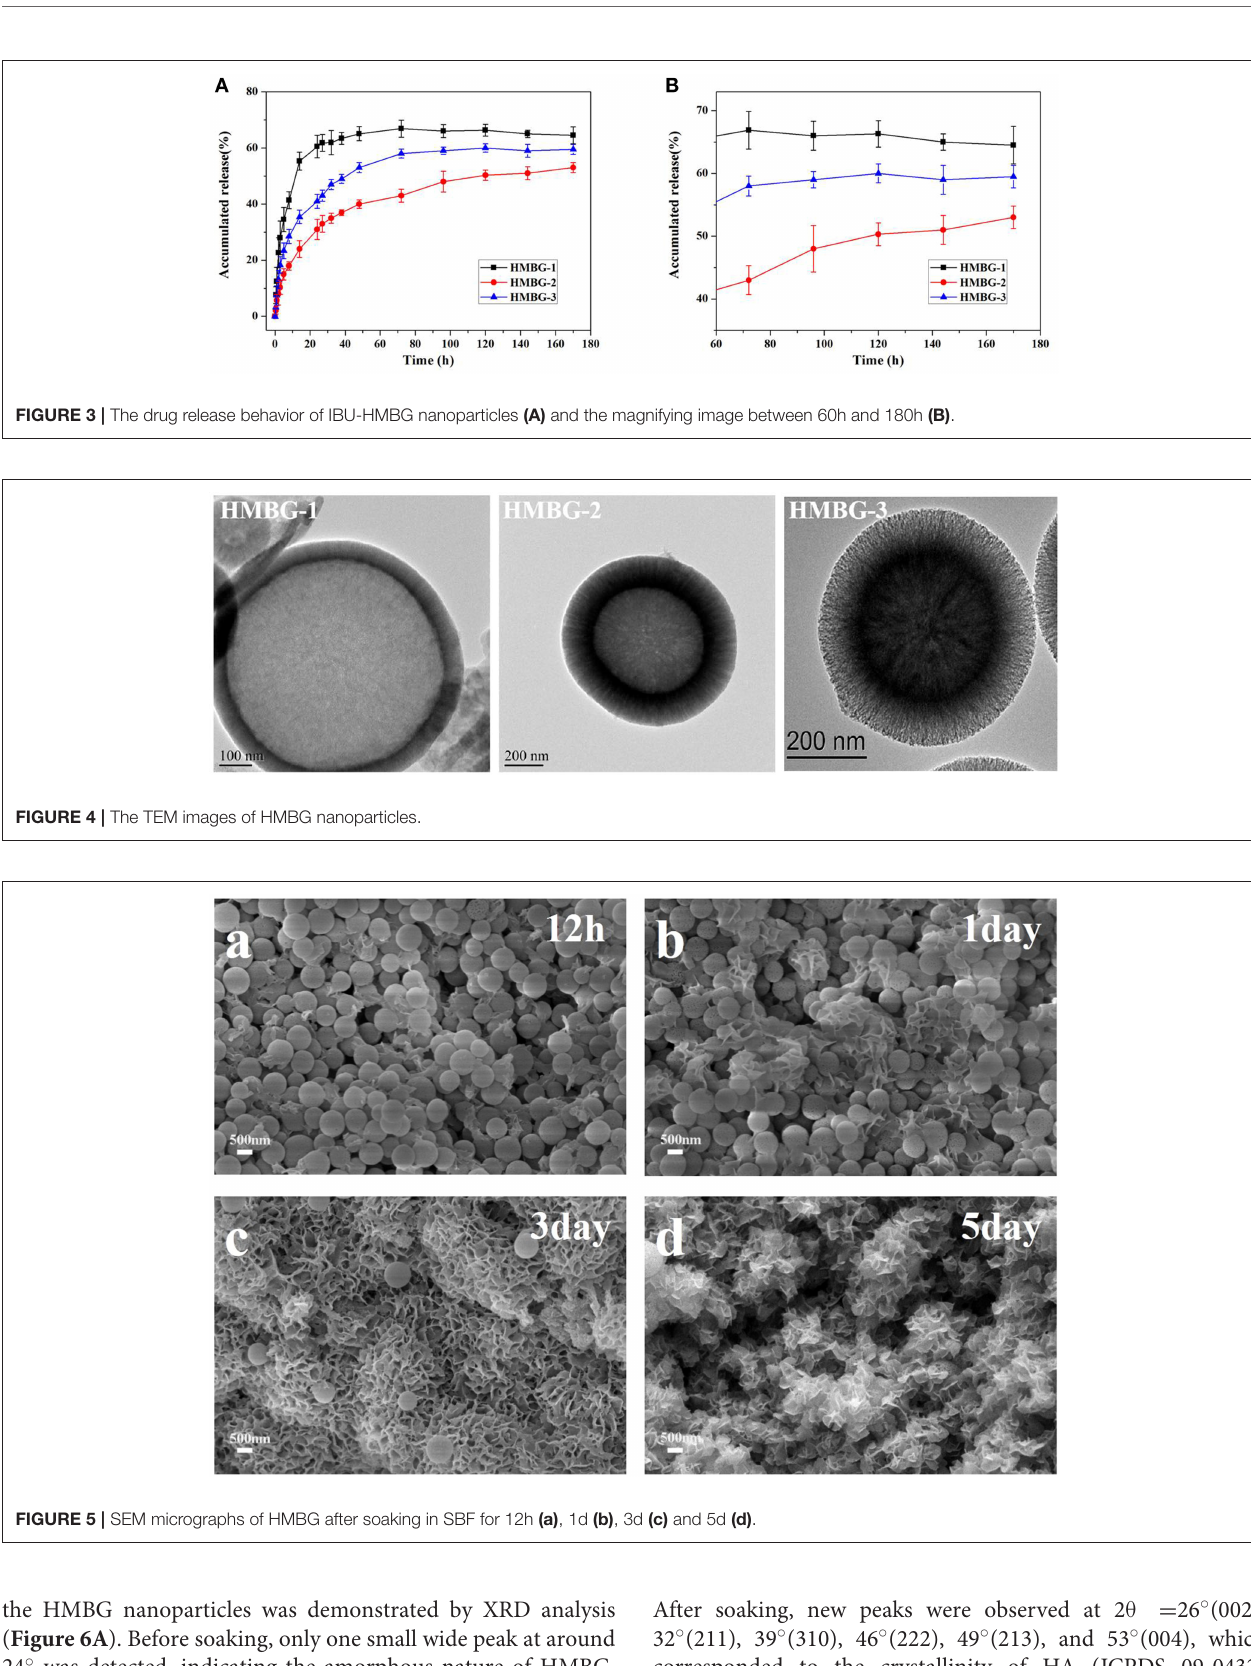
the HMBG nanoparticles was demonstrated by XRD analysis ( Figure 6A ). Before soaking, only one small wide peak at around 24 ◦ was detected, indicating the amorphous nature of HMBG.